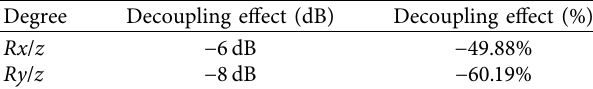
Figure 13: Comparison of random signal before and after decoupling with eccentric load. Table 2: Comparison of decoupling